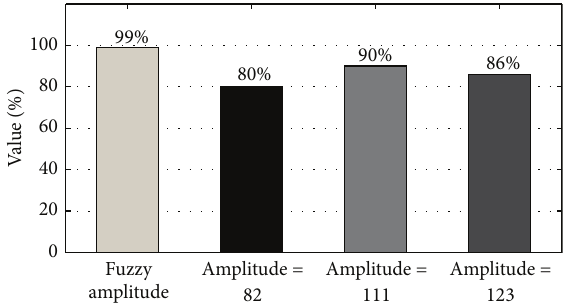
Figure 8: Throughput/Workload percentage